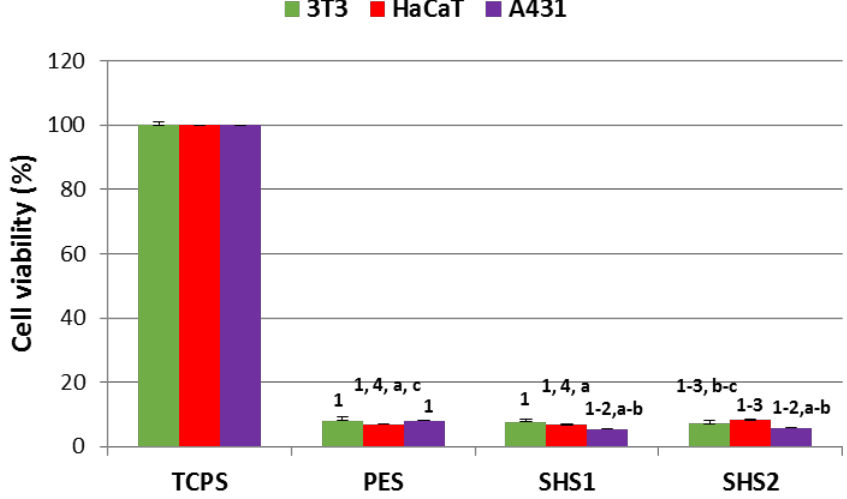
Figure 2. Relative viability of cell lines on unmodified and modified substrates, for 24 h, determined by MTT assay. The data corresponds to the average of three independent experiments ± standard deviation. Letter indicates significant differences ( p < 0.001) between the three cell lines for the same substrate (a: 3T3; b: HaCaT and c: A431). Number indicates significant differences ( p < 0.001) between the four substrates for the same cell line (1: TCPS; 2: PES; 3: SHS1; and 4: SHS2).